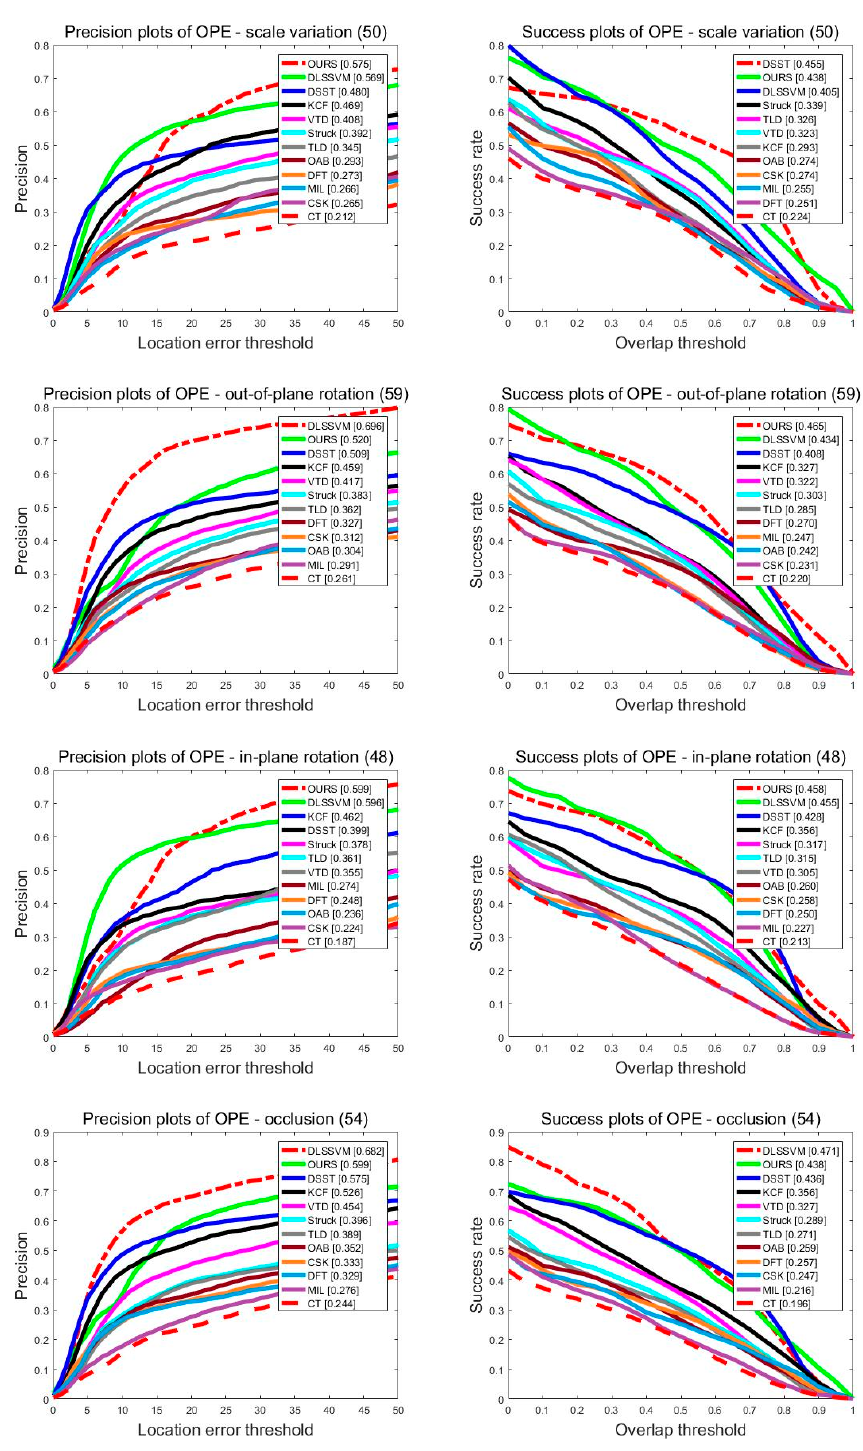
Figure 7. The precision plots and the success plots of sequences with non-rigid deformation, scale variation, rotation, and occlusion. The performance score of each tracker is shown in the